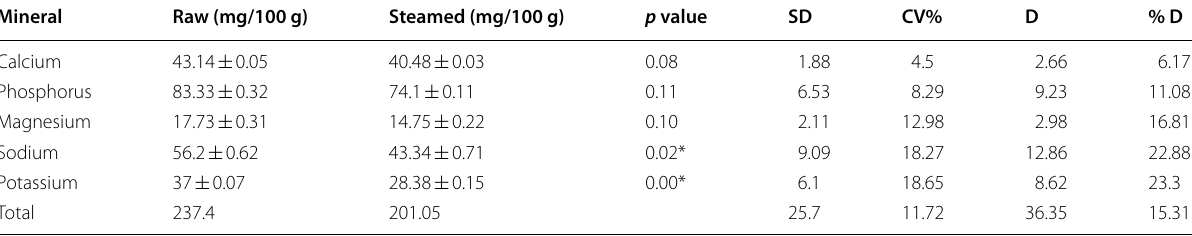
Standard deviation (SD), coefficient of variation per cent (CV %), difference between raw and cooked (D), percentage difference (D). p < 0.05 indicate significant difference Table 2 Mineral content of raw and steamed flesh of African Mud Creeper, T. fuscatus var radula